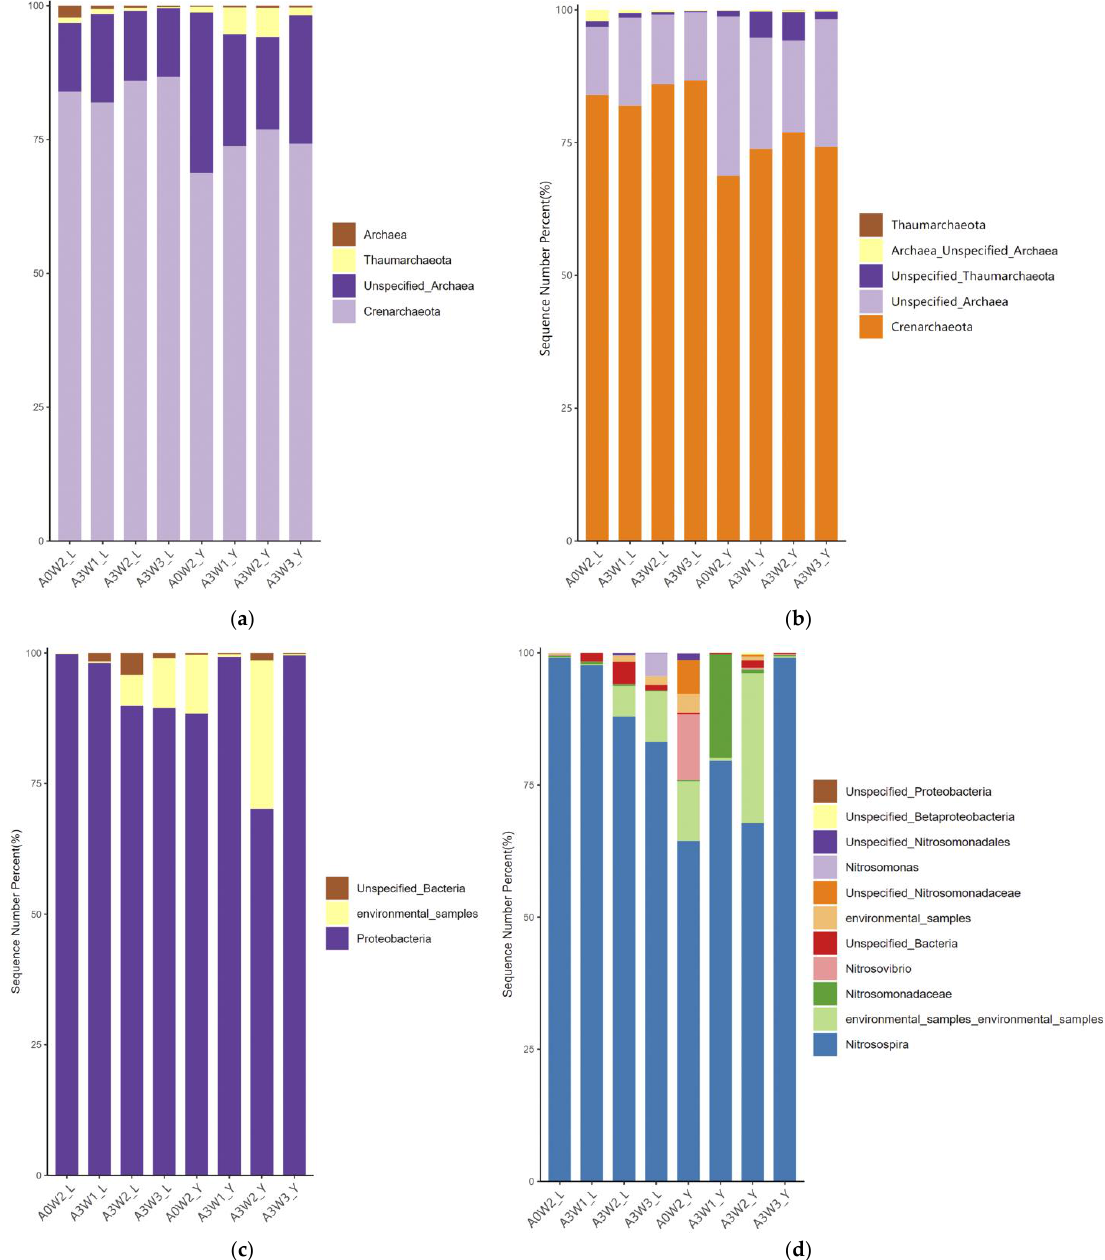
Figure 3. Relative abundance of AOA amoA ( a , b ) and AOB amoA ( c , d ) at the phyla, classes, and genera levels. A, the concentration gradient of the antibiotic sulfamethazine, including A0 (0 ng·L −1 ), A1 (500 ng·L −1 ), A2 (1500 ng·L −1 ), and A3 (3000 ng·L −1 ). W, irrigation methods, including W1 (flood irrigation), W2 (mild AWD), and W3 (severe AWD). _L and _Y indicate the late tillering and yellow ripening periods, respectively.